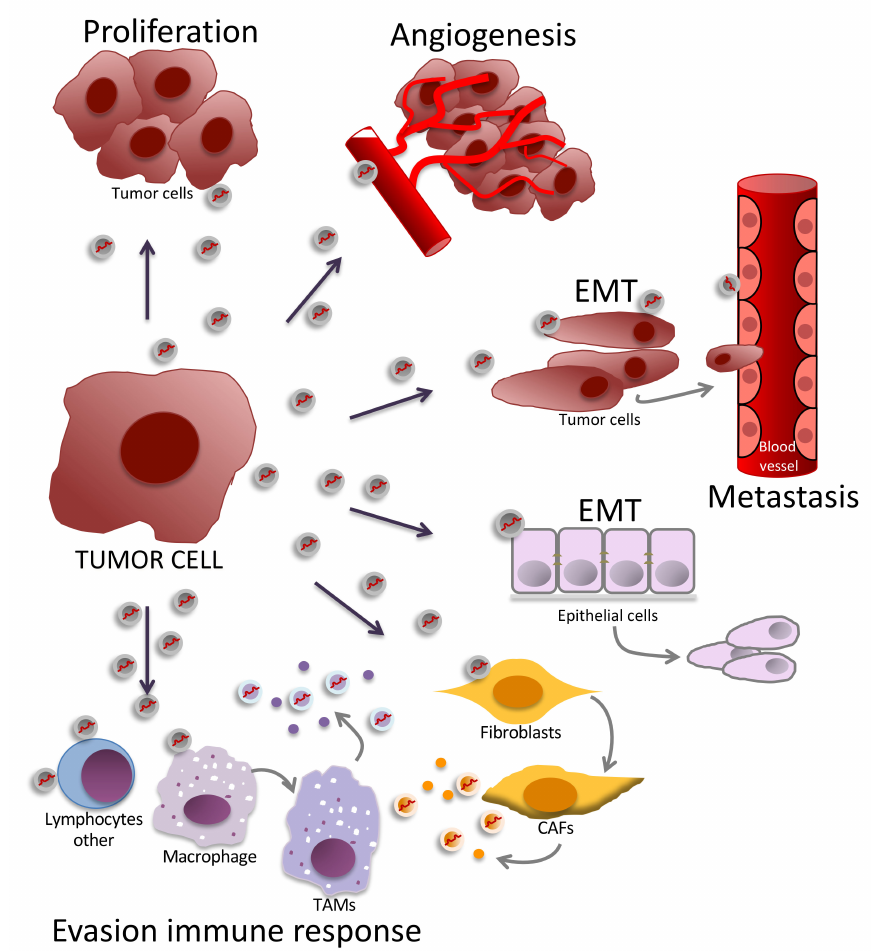
Figure 3. Extracellular miRNAs as intercellular mediators in cancer. In the tumor microenvironment, tumor cells release miRNAs into the extracellular space within exosomes which are delivered into other tumor cells or normal cells (resident and infiltrated cells), regulating biological processes related to cancer development and progression such as cellular proliferation, epithelial–mesenchymal transition (EMT), angiogenesis, metastasis, and the evasion of immune response. In addition to tumor cells, other cells, such as cancer-associated fibroblasts (CAFs) and tumor-associated macrophages (TAMs), release miRNAs as a mechanism of cancer regulation in addition to other soluble regulators such as cytokines as a mechanism of cancer